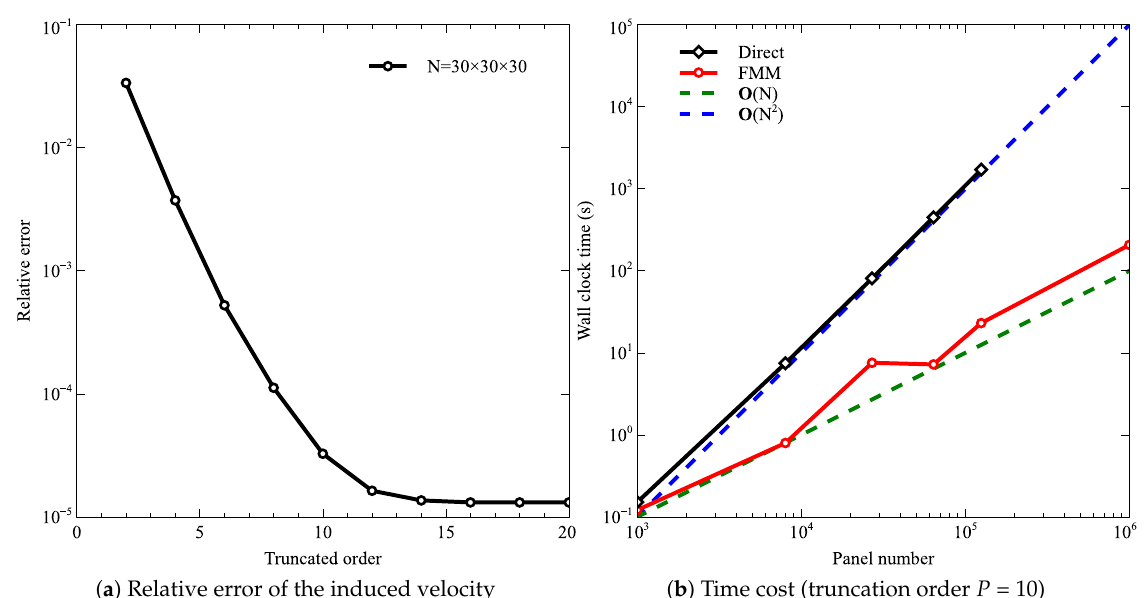
Figure 5. FMM for vortex